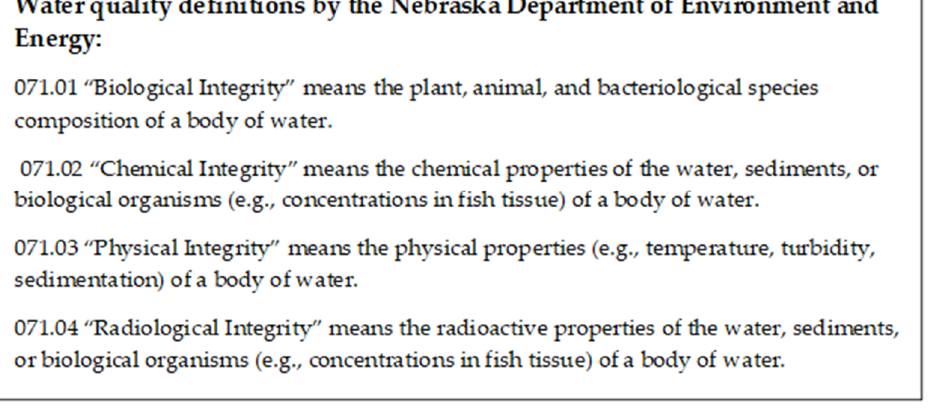
Figure 1. Water quality definitions by the Nebraska Department of Environment and Energy.